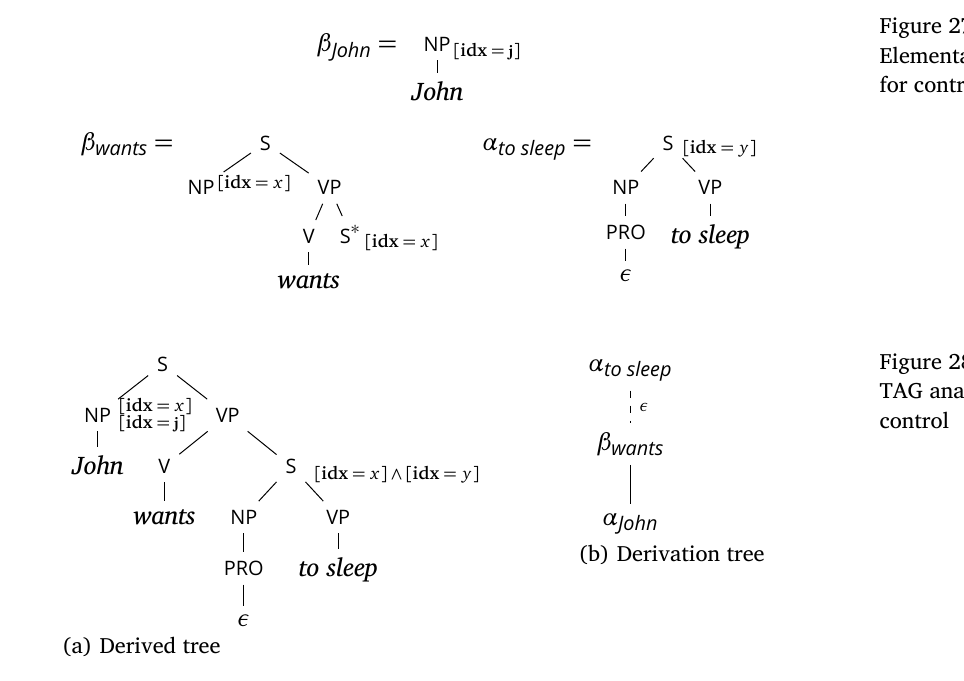
Figure 28: TAG analysis of